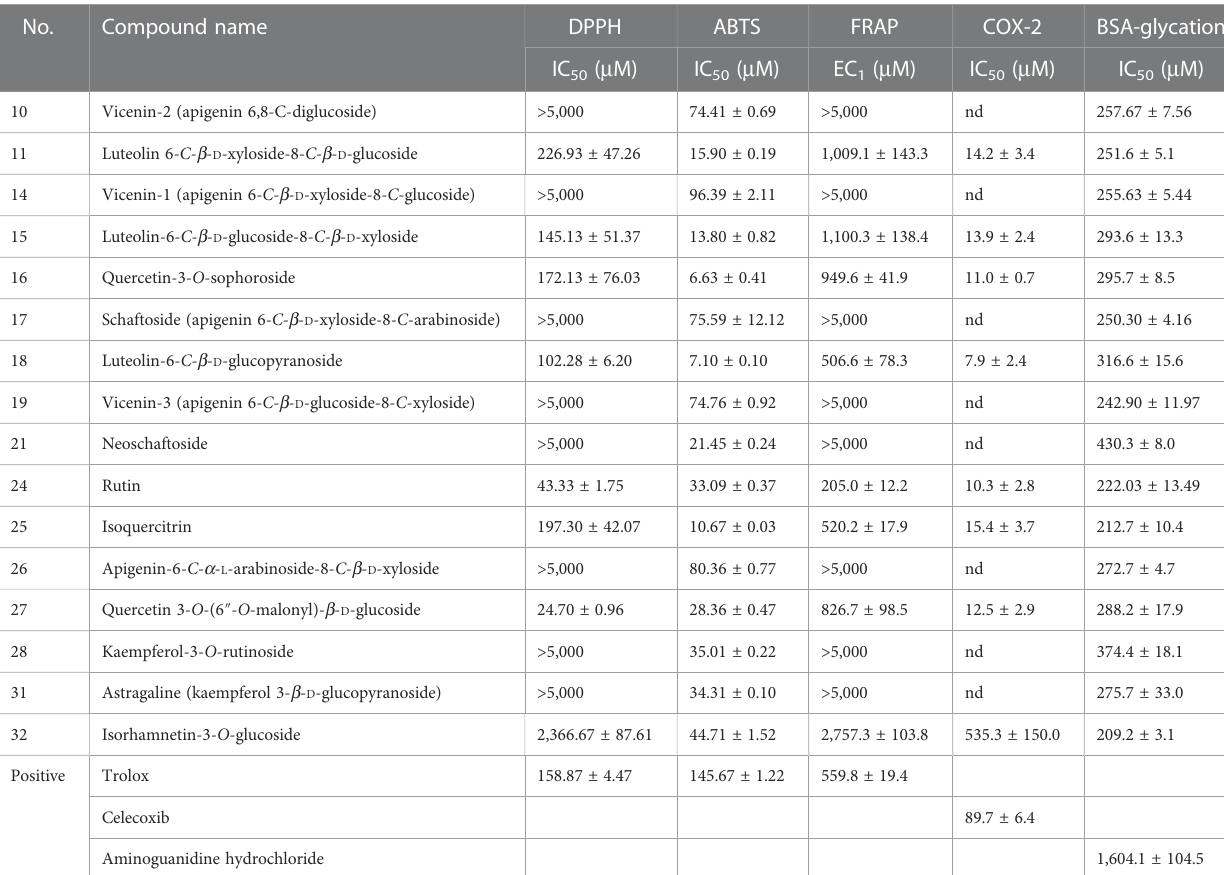
TABLE 2 Antioxidant (DPPH, ABTS, FRAP), anti-cyclooxygenase (COX-2), and AGE inhibition activity (BSA/reducing sugar reaction) (% of inhibition) of various compounds from Dendrobium of fi cinale fl ower-aqueous extract.